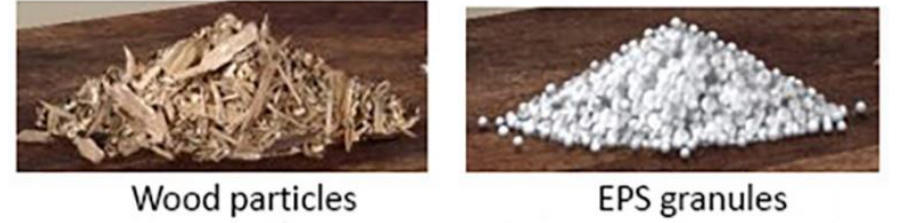
Figure 1. Wood particles and EPS granules used for manufacture of lightweight particleboards.